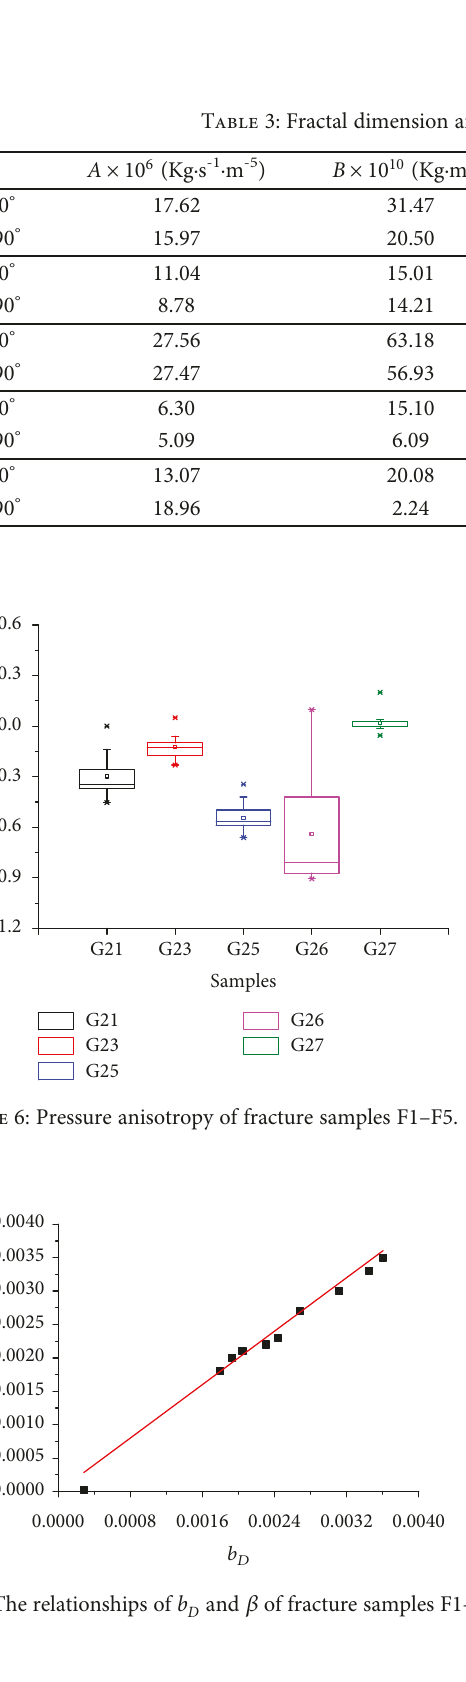
Figure 7: The relationships of b